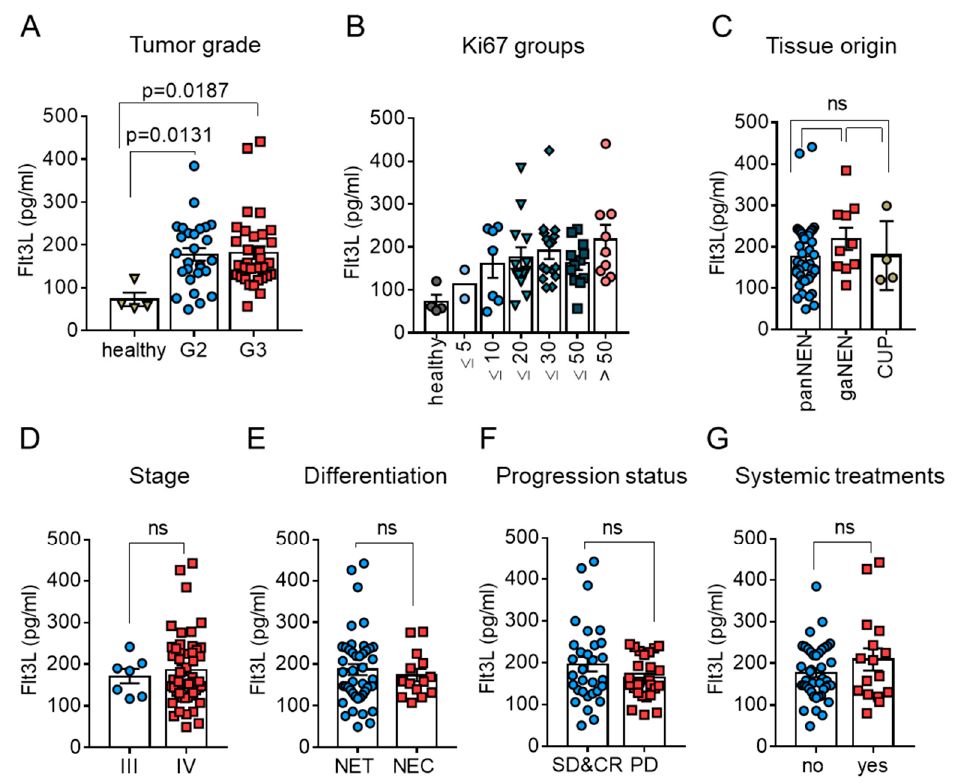
Figure 4. Relation of circulating Flt3L to established clinical features of NEN. Relation between circulating Flt3L and tumor grade ( A ) or ki67 fractions available from clinical records ( B ). Grading and ki67 information were matched as best as possible to the time of blood sampling. Control refers to healthy donor samples ( n = 4). Bars and error bars in ( A – E ) indicate mean ± SEM. Different tissue origin ( C ), presence or absence of metastases ( D ), or morphologic tumor differentiation ( E ) did not translate into differences in circulating Flt3L. Relation to progression status ( F ) and impact of ongoing systemic treatment ( G ). Samples from patients with stable disease (SD) or complete remission (CR) were combined and compared to samples from patients with progressive disease (PD). Systemic treatments included chemotherapies, targeted therapies and PRRT. Kruskall–Wallis ( A ) and Mann–Whitney tests ( C – G ) were used for determination of p -values; p > 0.05 was considered not significant (ns).